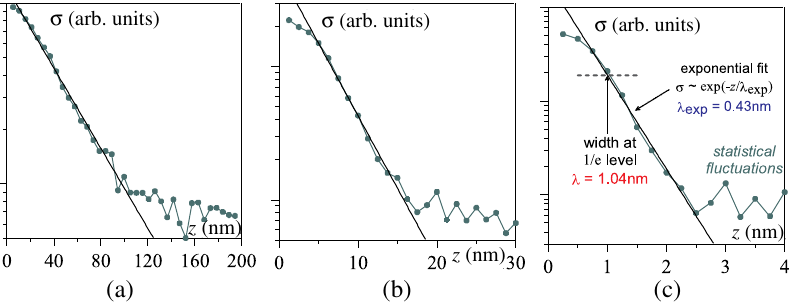
FIG. 7. Distribution of the plasma charge (in arbitrary units) over the longitudinal direction (log-linear plot). The solid line represents the exponential fit, (a) n e ¼ 10 23 m (cid:1) 3 (b) n e ¼ 10 25 m (cid:1) 3 , (c) n e ¼ 10 27 m (cid:1) 3 . In all cases T ¼ 1 eV .